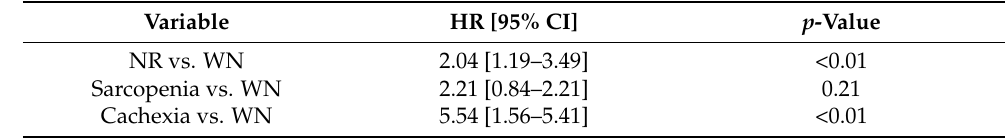
Table 3. Prognostic value of the baseline NS for OS.